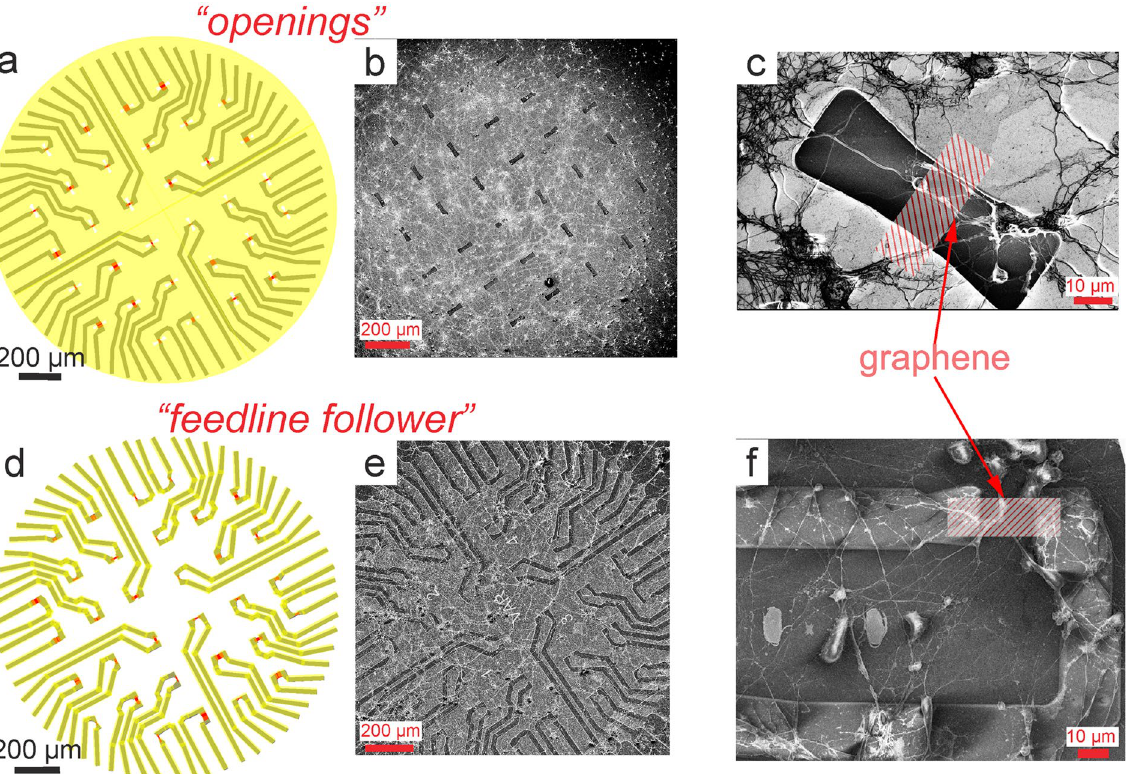
Figure 7. ( a ) and ( d ) represent the passivation openings and feedline follower technique respectively. The passivation is shown in yellow, openings/substrate in white and graphene in red. ( b ) and ( e ) represent SEM images of both kinds of chips with a neuronal network cultured on top, and zoom-ins into one GFET area are given in ( c ) and ( f ) for passivation openings and feedline follower technique respectively. Details on fixation and imaging are given in Methods. Due to the sputtered layer of Pt (required to visualise non-conducting neurons and dielectrics), graphene is not visible. In ( b ) and ( c ), due to a large layer of passivation, the openings look dark in the SEM image, while opposite situation in ( e ) and ( f ), where passivation covers the metal feedlines and are represented